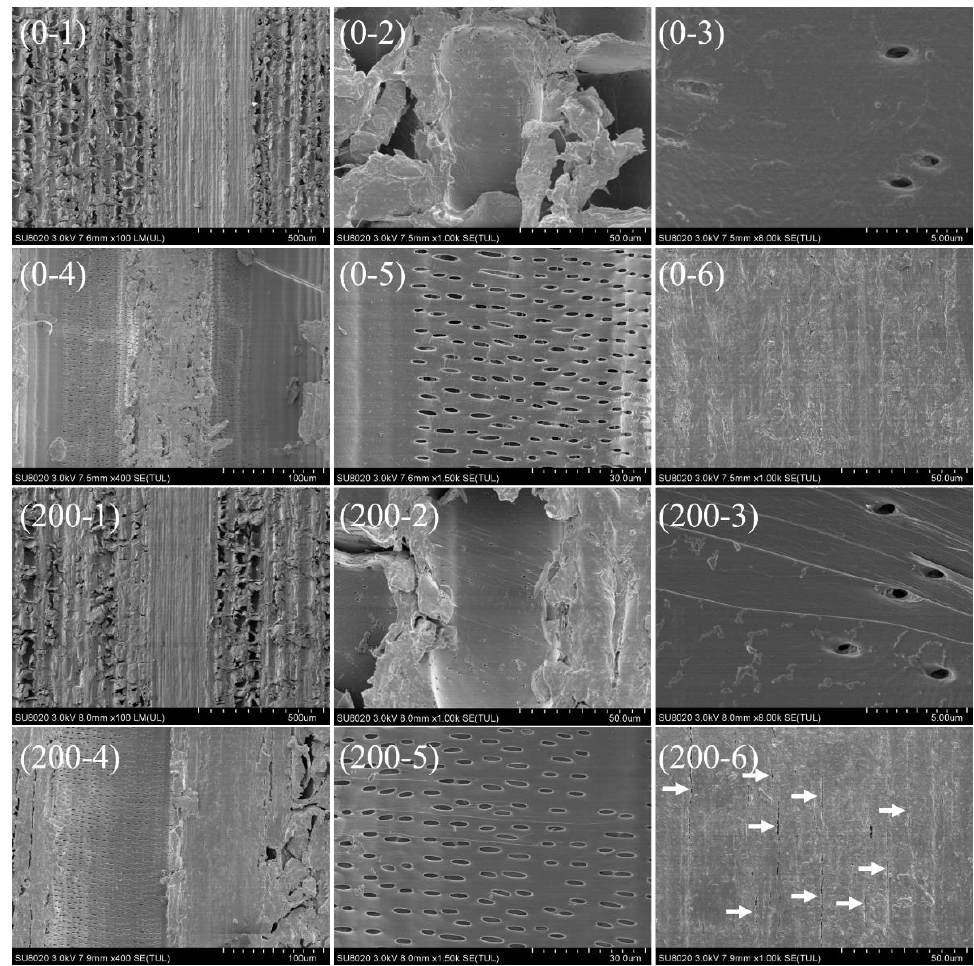
Figure 3. SEM image of a tangential section of NB (0-N) before and (200-N) after UV irradiation for 200 h. Note: N (1 to 6) denotes different regions of the tangential section.